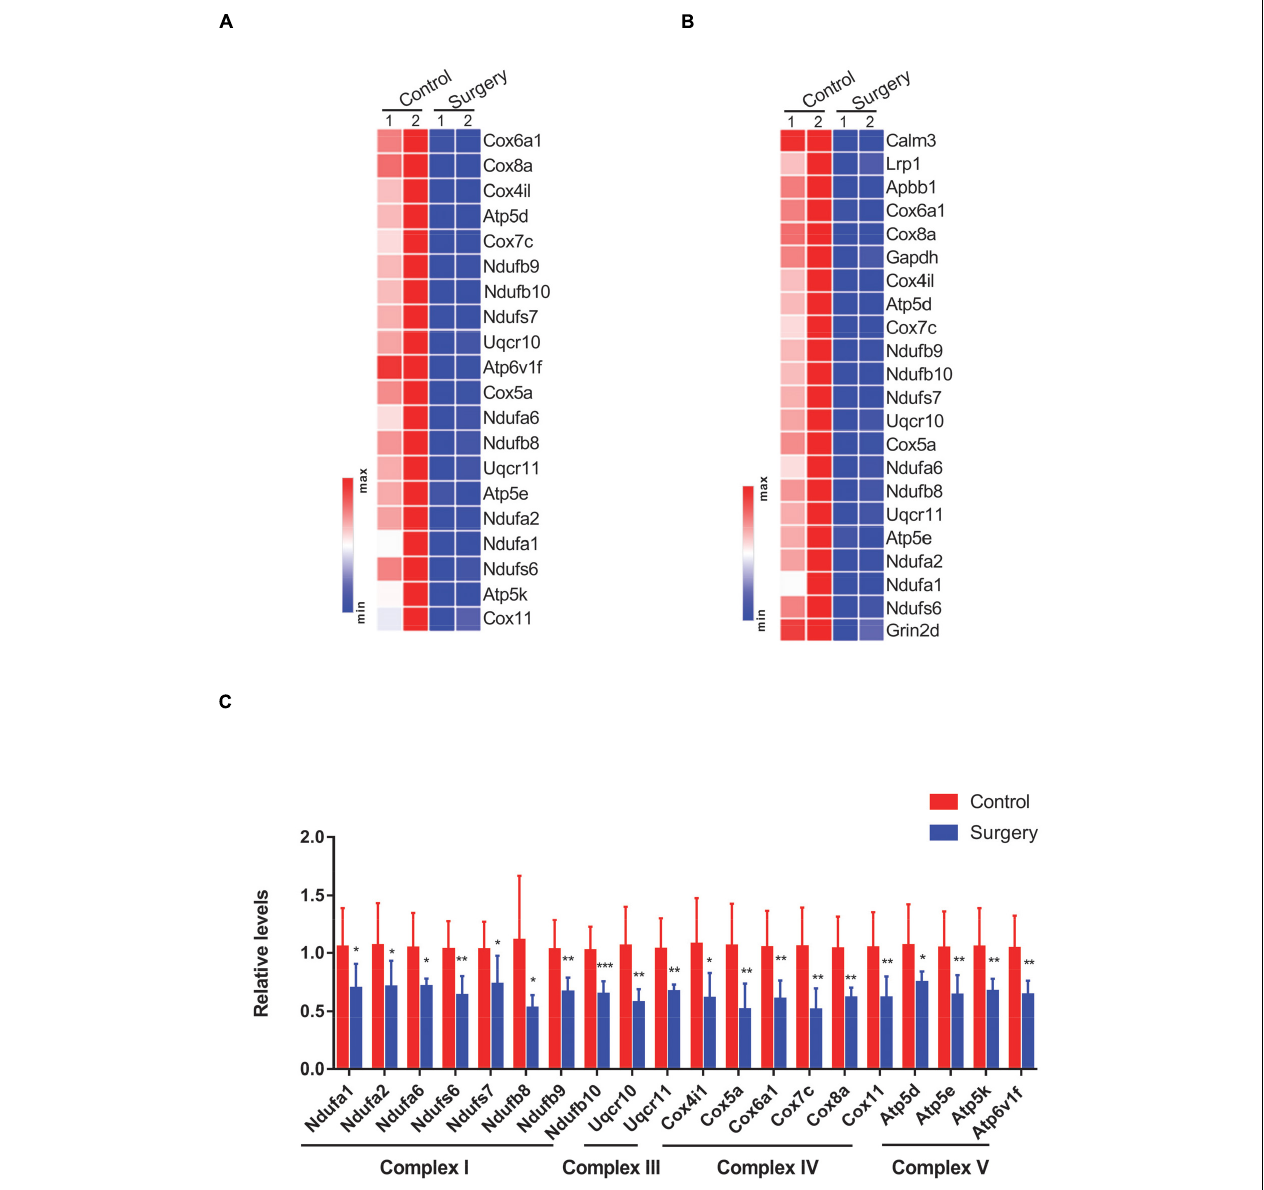
FIGURE 3 | Differential expression of oxidative phosphorylation-related genes was visualized in heatmaps and validated by Quantitative PCR (qPCR). (A,B) Genes enriched in the “oxidative phosphorylation” (A) and “Alzheimer’s disease” (B) terms from Kyoto Encyclopedia of Genes and Genomes (KEGG) pathway analysis are visualized in heatmaps. (C) Levels of oxidative phosphorylation-related genes in respiratory chain complexes in control vs. surgery mice were determined by qPCR-based analysis. β -actin was included as an internal control. Data are presented as fold changes in the surgery over controls ( n = 8 per group). * P < 0.05; ** P < 0.01; *** P < 0.001 by independent samples Student’s t -test; error bars denote the